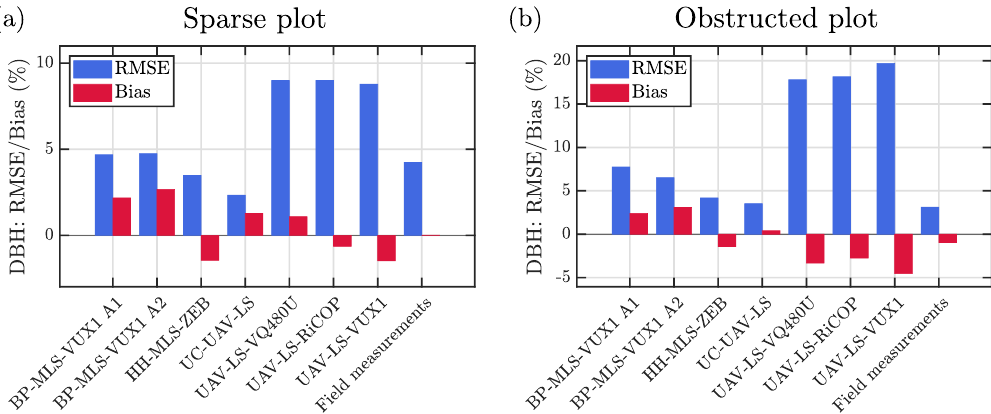
Figure 9. Relative bias and RMSE of DBH estimation at the individual tree level for the different MLS methods ( a ) in the sparse plot and ( b ) in the obstructed plot. BP, HH, and UC stand for backpack, handheld, and under-canopy, respectively. Note that the scales of the y axes are different in panels ( a , b ). For the above-canopy UAV measurements, the RMSE of DBH estimation was significantly